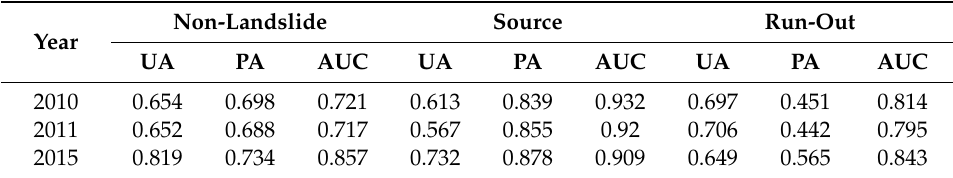
Table 7. Prediction of Model-1 using the later-record samples. AUC—area under the receiver operating characteristics